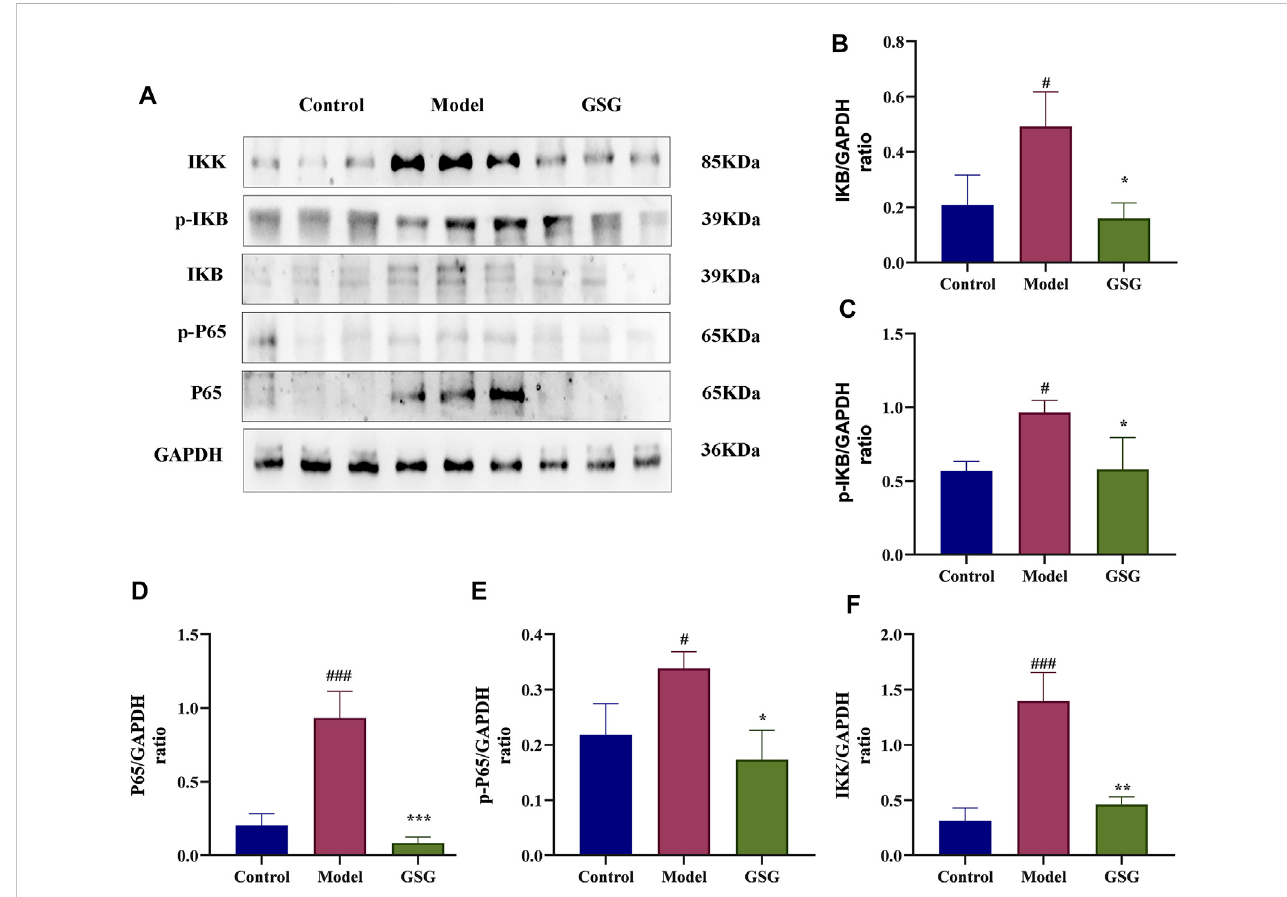
FIGURE 9 Inhibition of the NF- κ B/I κ B signaling pathway by GSG in NASH rats. (A) Protein blotting bands of P65, p-P65, I κ B, p-I κ B, and IKK in each group of liver samples. (B – F) Grayscale analysis of the protein expression of P65, p-P65, I κ B, p-I κ B, and IKK in each group of liver samples, using GAPDH as an internal reference. Data are the mean ± S.E.M.; # p < 0.05, ## p < 0.01, #### p < 0.0001 vs. control; * p < 0.05, ** p < 0.01, *** p < 0.001 vs. model; n =